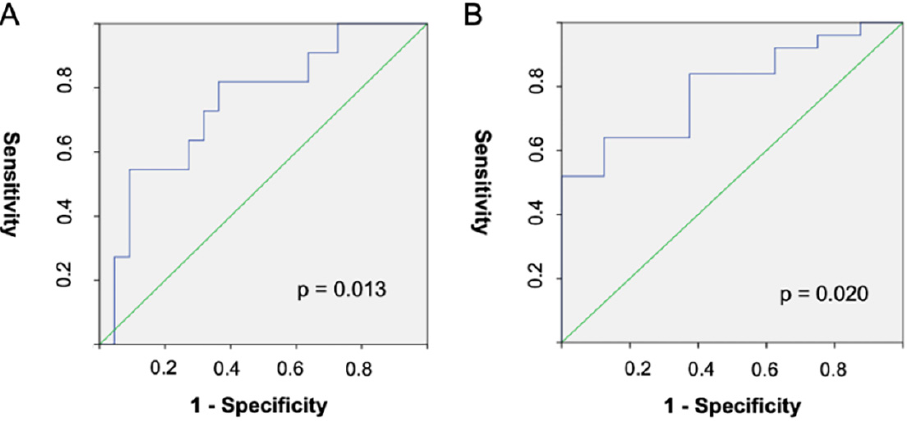
Figure 4. Receiver operating curves for quantitative PBV and cardiac index ≥ 2.5 L/min/m 2 ( A ) or cardiac index ≥ 2 L/min/m 2 ( B ).